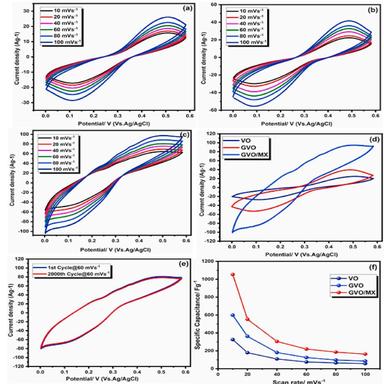
(a–c) CV profiles of VO, GVO and GVO/MX at sweep rate changing from 10 mVs− 1 to 100 mVs− 1 , (d) Comparative CV loops of VO, GVO and GVO/MX, (e) CV plots of GVO/MX at 1st and 1000th cycle to check stability, (f) Change in Csp as a function of sweep rate for VO, GVO and GVO/MX.